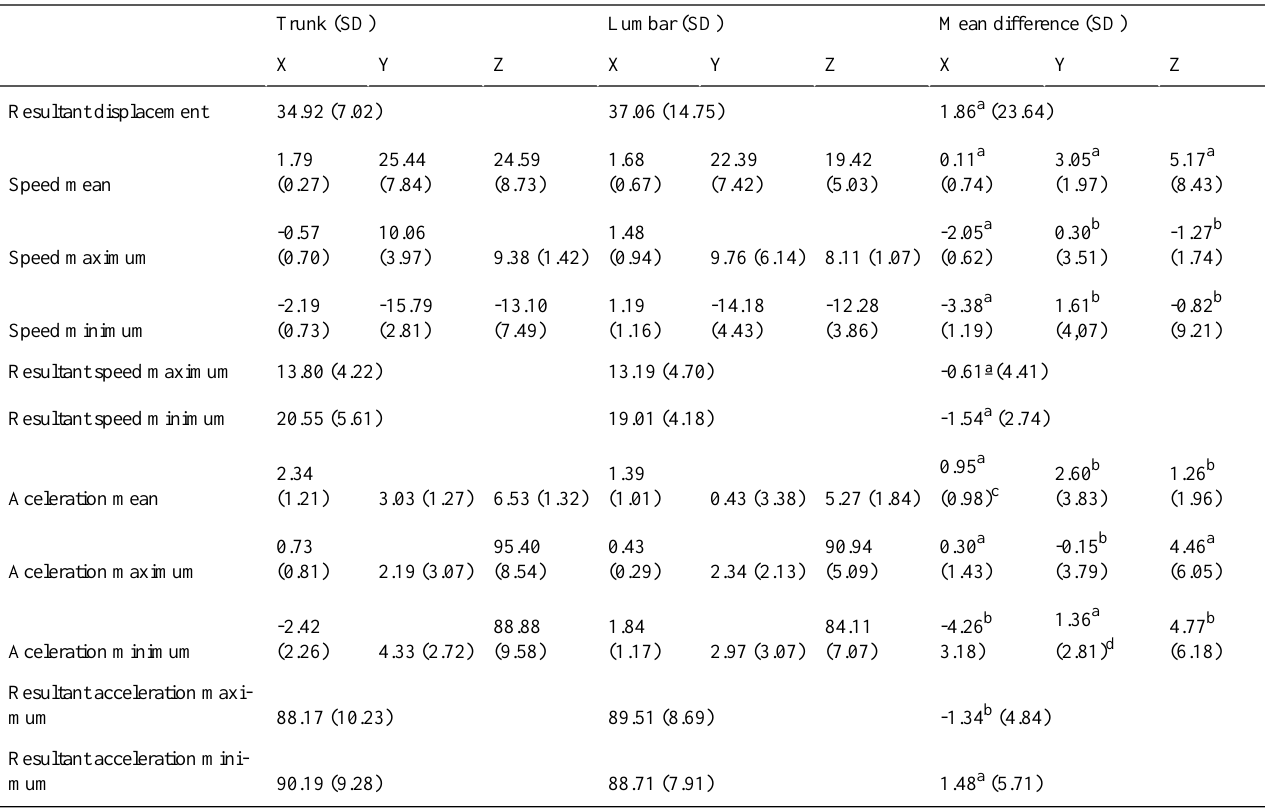
Table 3. Mean and standard deviation of the records of each of the sensors and differences between